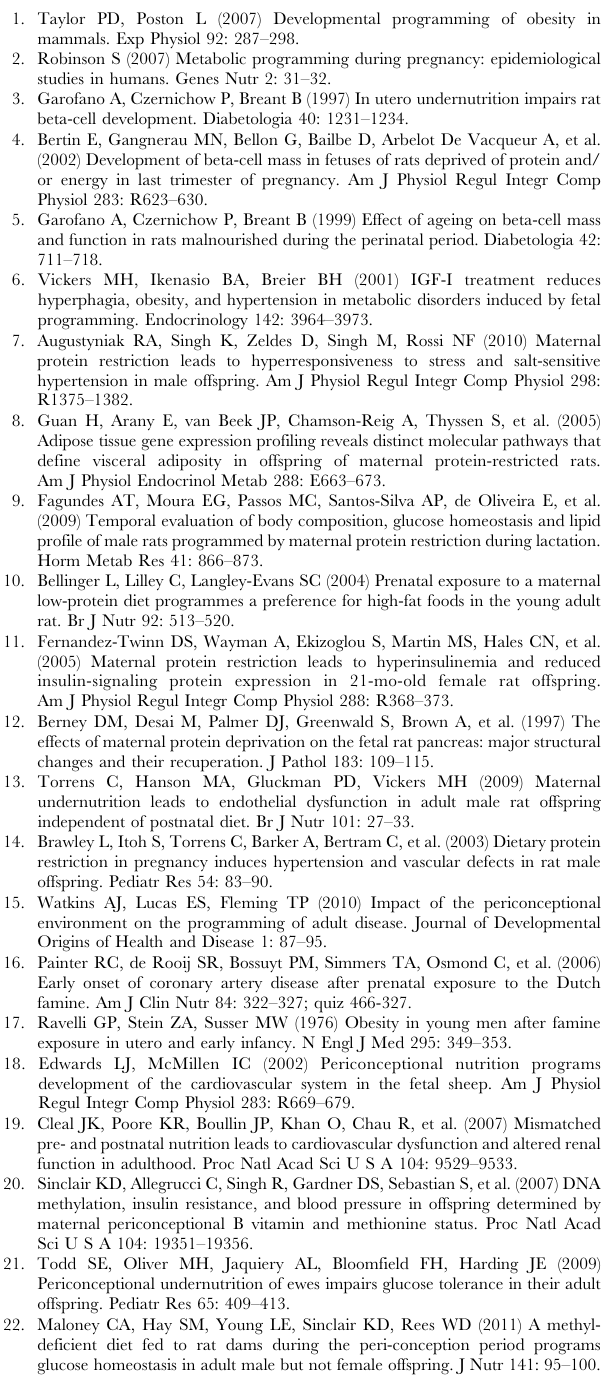
Table S1 Mean organ weight and organ: body weight ratios for male and female offspring. Values are means 6 SEM for 9–13, 11–12, 9–12, 8–10 and 9–11 Egg-NPD, Egg-LPD, NPD, LPD and Emb-LPD males and females respectively; * P #